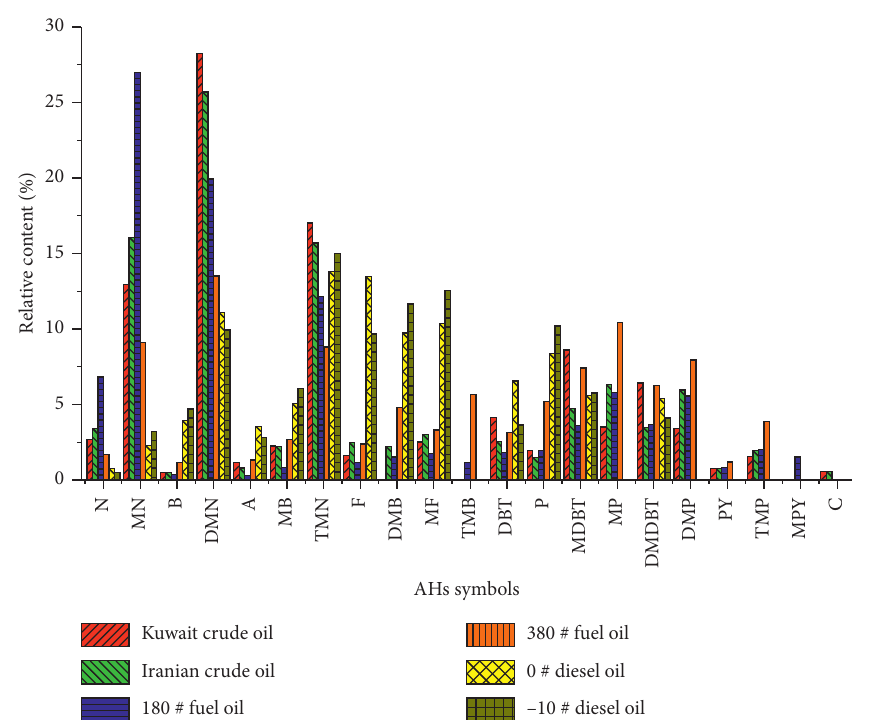
Figure 2: Relative content of AHs in six oil samples determined by GC-MS analysis. Naphthalene (N); methylnaphthalene (MN); dimethylnaphthalene (DMN); trimethylnaphthalene (TMN); biphenyl (B); methylbiphenyl (MB); dimethylbiphenyl (DMB); acenaphthene (A); fluorene (F); methylfluorene (MF); dibenzothiophene (DBT); methyldibenzothiophene (MDBT); dimethyldibenzothiophene (DMDBT); phenanthrene (P); methylphenanthrene (MP); dimethylphenanthrene (DMP); trimethylphenanthrene (TMP); pyrene (PY); methylpyrene (MPY); and chrysene